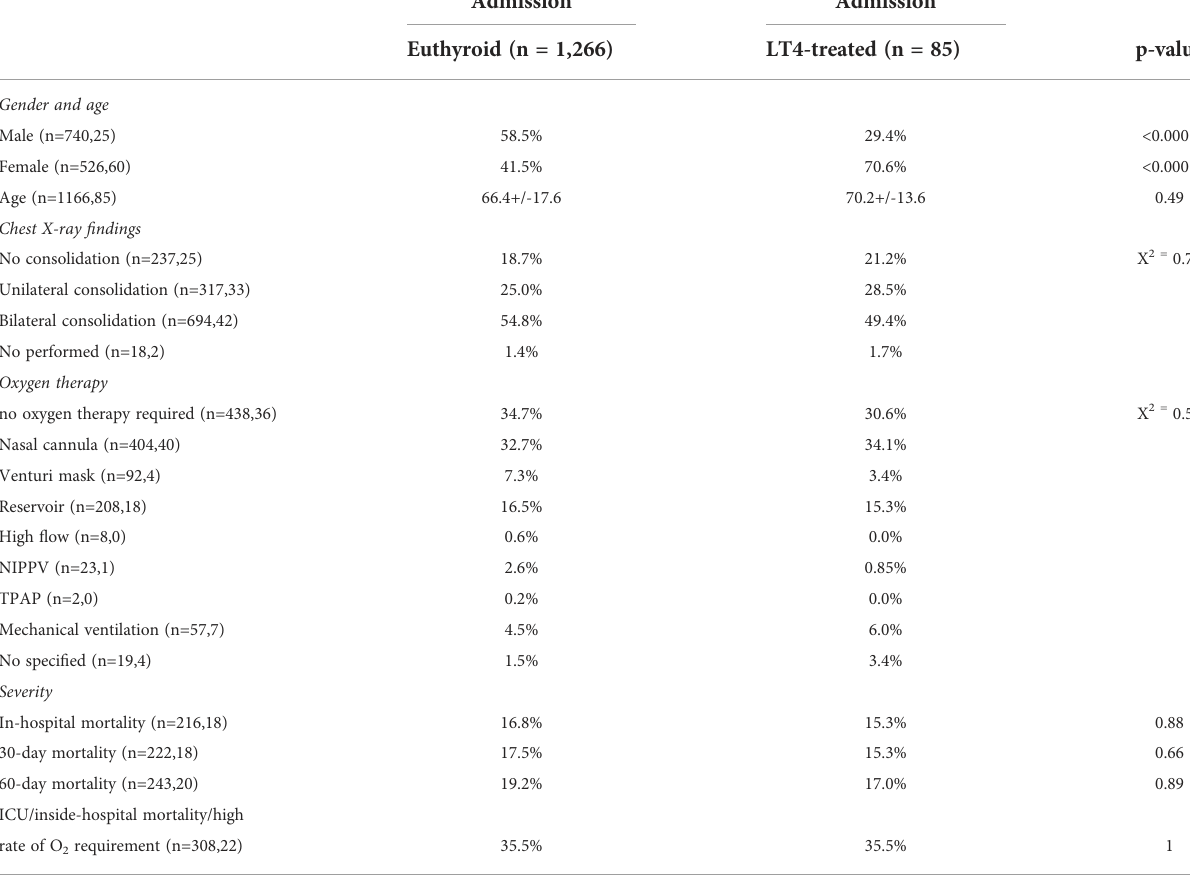
TABLE 4 Gender, age, severity and mortality within 30 and 60 days in hospitalized COVID-19